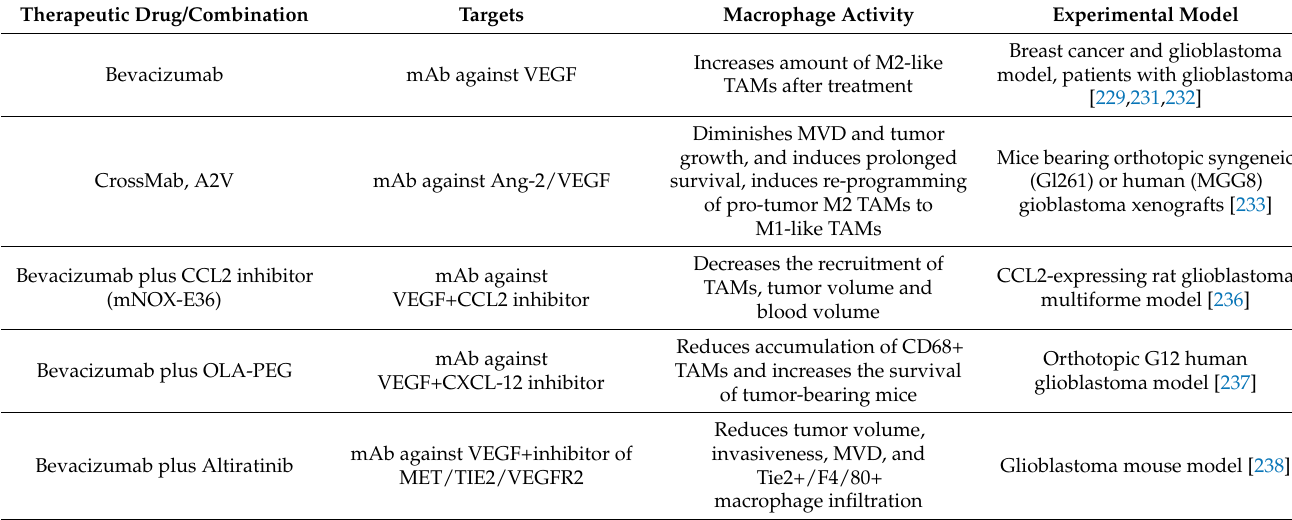
Table 3. The effect of FDA-approved anti-angiogenic therapy on macrophage